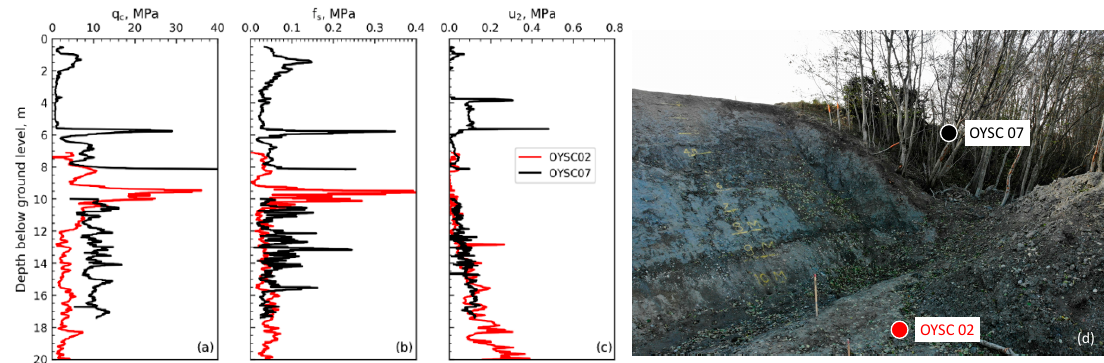
Figure 3. Cone penetration tests (CPTu)s close to the slope at Øysand: ( a ) qc, ( b ) fs, ( c ) u2, and ( d ) location of CPTu.